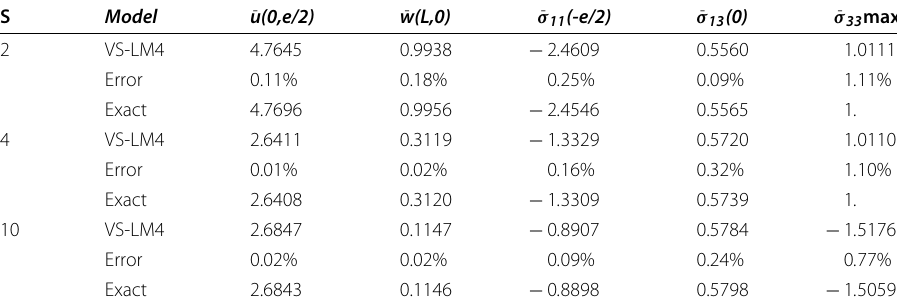
Table 4 One layer [0 ◦ ] — φ = π/ 3 —mesh 26 × 10— N z = 4 × NC —two-order expansion of